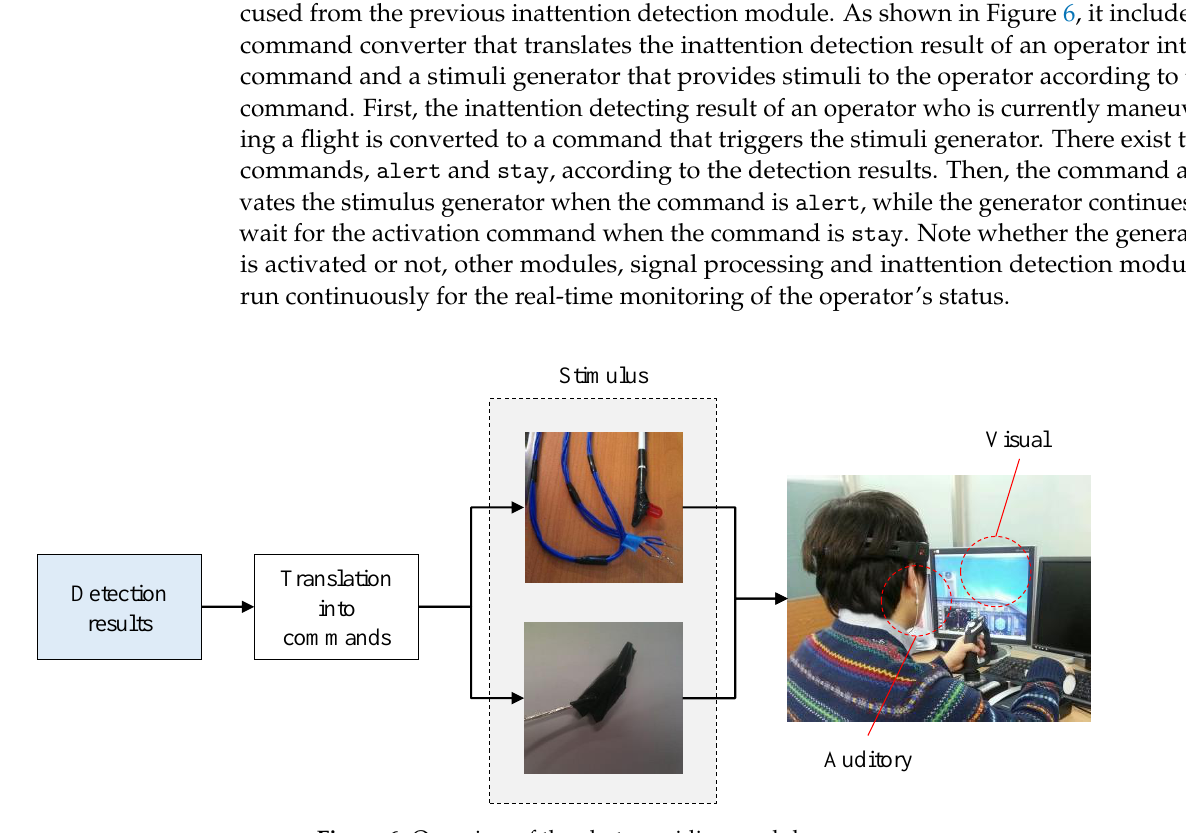
Figure 6. Overview of the alert providing